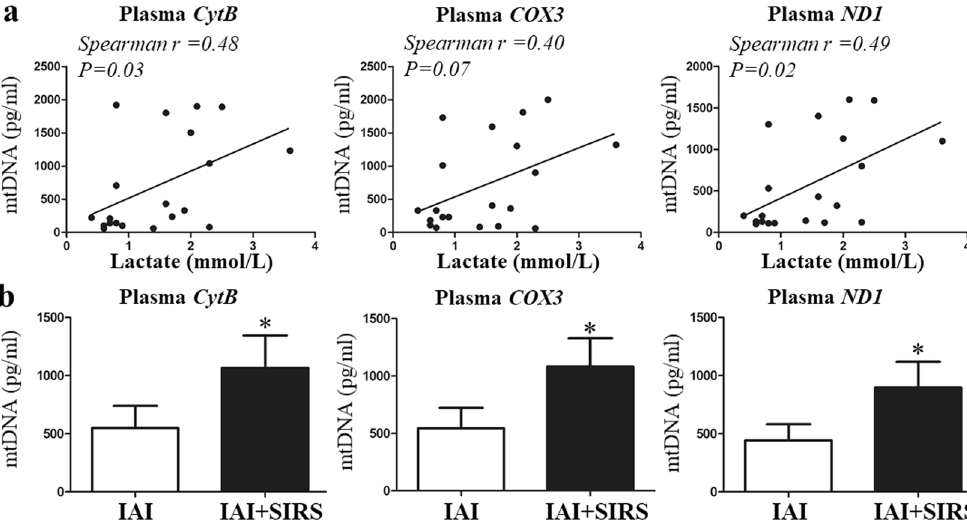
Figure 1. The plasma mtDNA level is increased in IAI patients and is correlated with the lactate level. Three selected sequences were used to detect the mtDNA levels using qPCR. ( a ) Correlations between the baseline mtDNA levels and admission lactate concentration. ( b ) Plasma mtDNA levels between the IAI group and IAI + SRIS group. mtDNA concentrations are presented as means ± SD. * means P <